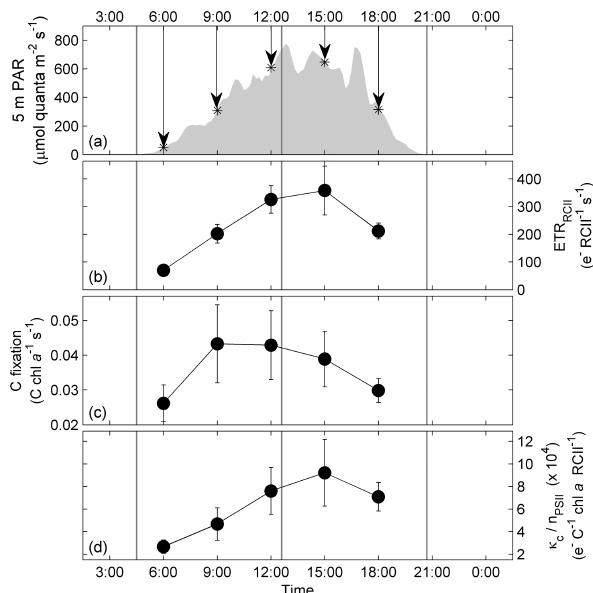
Figure 3. Diurnal changes in ETR RCII , carbon fixation, and K c /n PSII derived for in situ light intensities at 5m depth. Diur- nal changes in irradiance at 5m depth (a) , with arrows indicating the PAR value used to derive rates in (b) and (c) . Realized rates of ETR RCII (b) and carbon fixation (c) at each time point were derived from the P vs. E relationship established in Fig. 1. The error in (b) and (c) is the propagated 95% confidence interval of the parameter P vs. E fit parameters, and the error in (d) is the propagated error from (b) / (c) . The vertical gray lines in all plots mark sunrise, solar noon, and sunset.